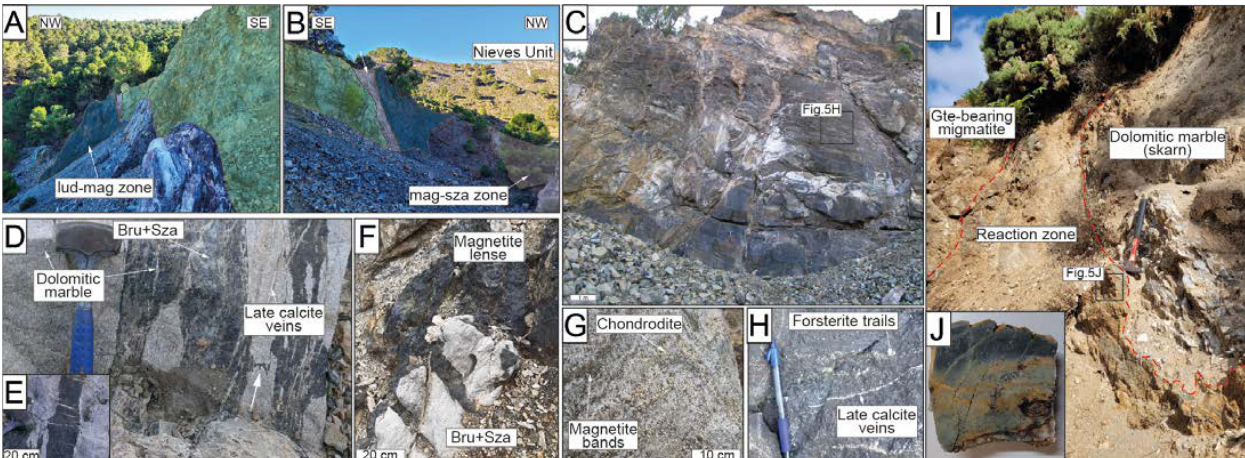
Figure 3. Field images of the El Robledal deposits and host rocks. The ludwigite–magnetite zone (i.e., lud–mag) is marked with a dark-blue marked area, whereas the magnetite–szaibelyite (i.e., mag–sza) zone is marked with a light-brown area. The Ronda Peridotites are marked with a pale-green area. A fault zone separating the lud–mag zone from the serpentinized Ronda Peridotites is marked with a white-colored area. ( A ) Close-up view of the tectonic contact between Ronda Peridotites and the deposit; ( B ) panoramic view of the mining area showing the whole sequence of the deposit; ( C ) upper mineralized body representing the ludwigite–magnetite zone; ( D ) massive magnetite bands of the magnetite–szaibelyite zone, where the white arrow marks a highly deformed magnetite band; ( E ) detailed view of the pull-apart fractures of the magnetite bands from the magnetite–szaibelyite zone; ( F ) small-scale magnetite body within the dolomitic marble associated with a brucite+szaibelyite groundmass; ( G ) chondrodite-bearing marble with folded magnetite bands. Note that chondrodite is overall associated with magnetite bands; ( H ) close-up view of the massive texture of the upper body of the deposit (i.e., ludwigite–magnetite zone). Note the occurrence of trails of green-colored forsterite and late calcite veins; ( I ) field view of the amphibolite reaction zone limiting the skarn from the migmatites of the Blanca Unit. The dashed, red line highlights the sharp contact of the amphibolite with surrounding rocks; ( J ) amphibolite section obtained from the reaction zone. Lud: ludwigite; Mag: magnetite; Sza: szaibelyite.